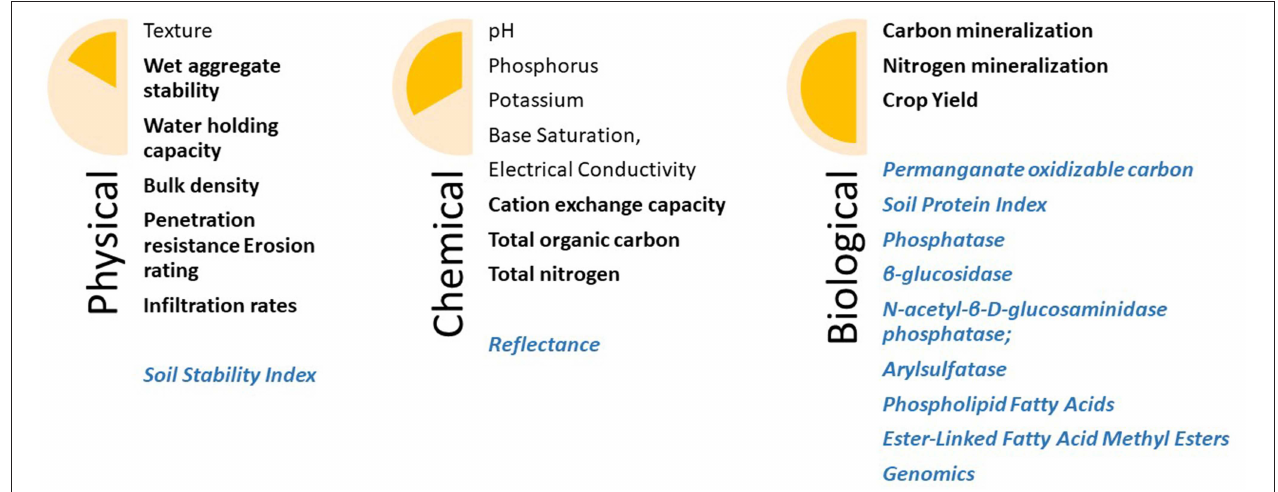
FIGURE 2 | Soil quality indicators recommended for inclusion in the U.S. minimum data set with variables that integrate change in years to decades (bold), that are considered Tier 1 (Black) and Tier 2 (Blue Italics) by the Soil Health Institute (https://soilhealthinstitute.org/north-american-project-to-evaluate-soil-health- measurements/) and NRCS SHD 2018 Federal Register Notice Docket No. NRCS-2018-0006 ( NRCS, 2018), Notice of Recommended Standard Methods for use as Soil Health Indicator https://www.federalregister.gov/documents/2018/09/14/2018-19985/notice-of-recommended-standard-methods-for-use-as-soil-health- indicator-measurements. NCERA-59’s 1994 MDS included: Physical (Texture, Bulk Density, Depth of Rooting, Infiltration, Water Holding Capacity, Soil Structure); Chemical (pH, N, P, K, EC, Soil Organic Matter); and Biological (Active C, Potentially Mineralizable N, Soil Respiration, Crop Yield)